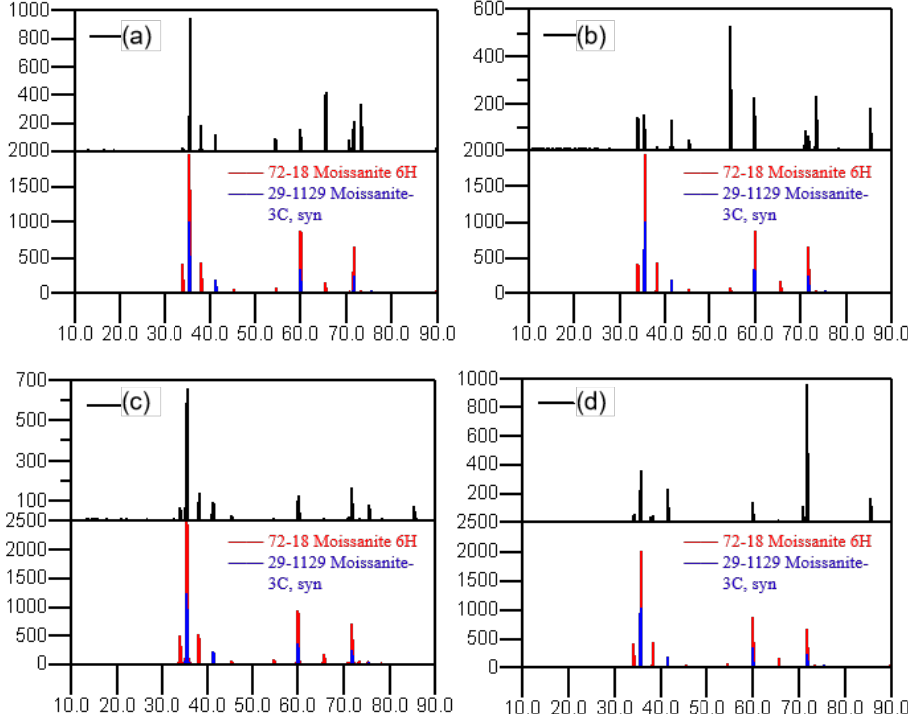
Figure 5. XRD patterns after different processes. ( a ) process A; ( b ) process B; ( c ) process C; ( d ) process D.